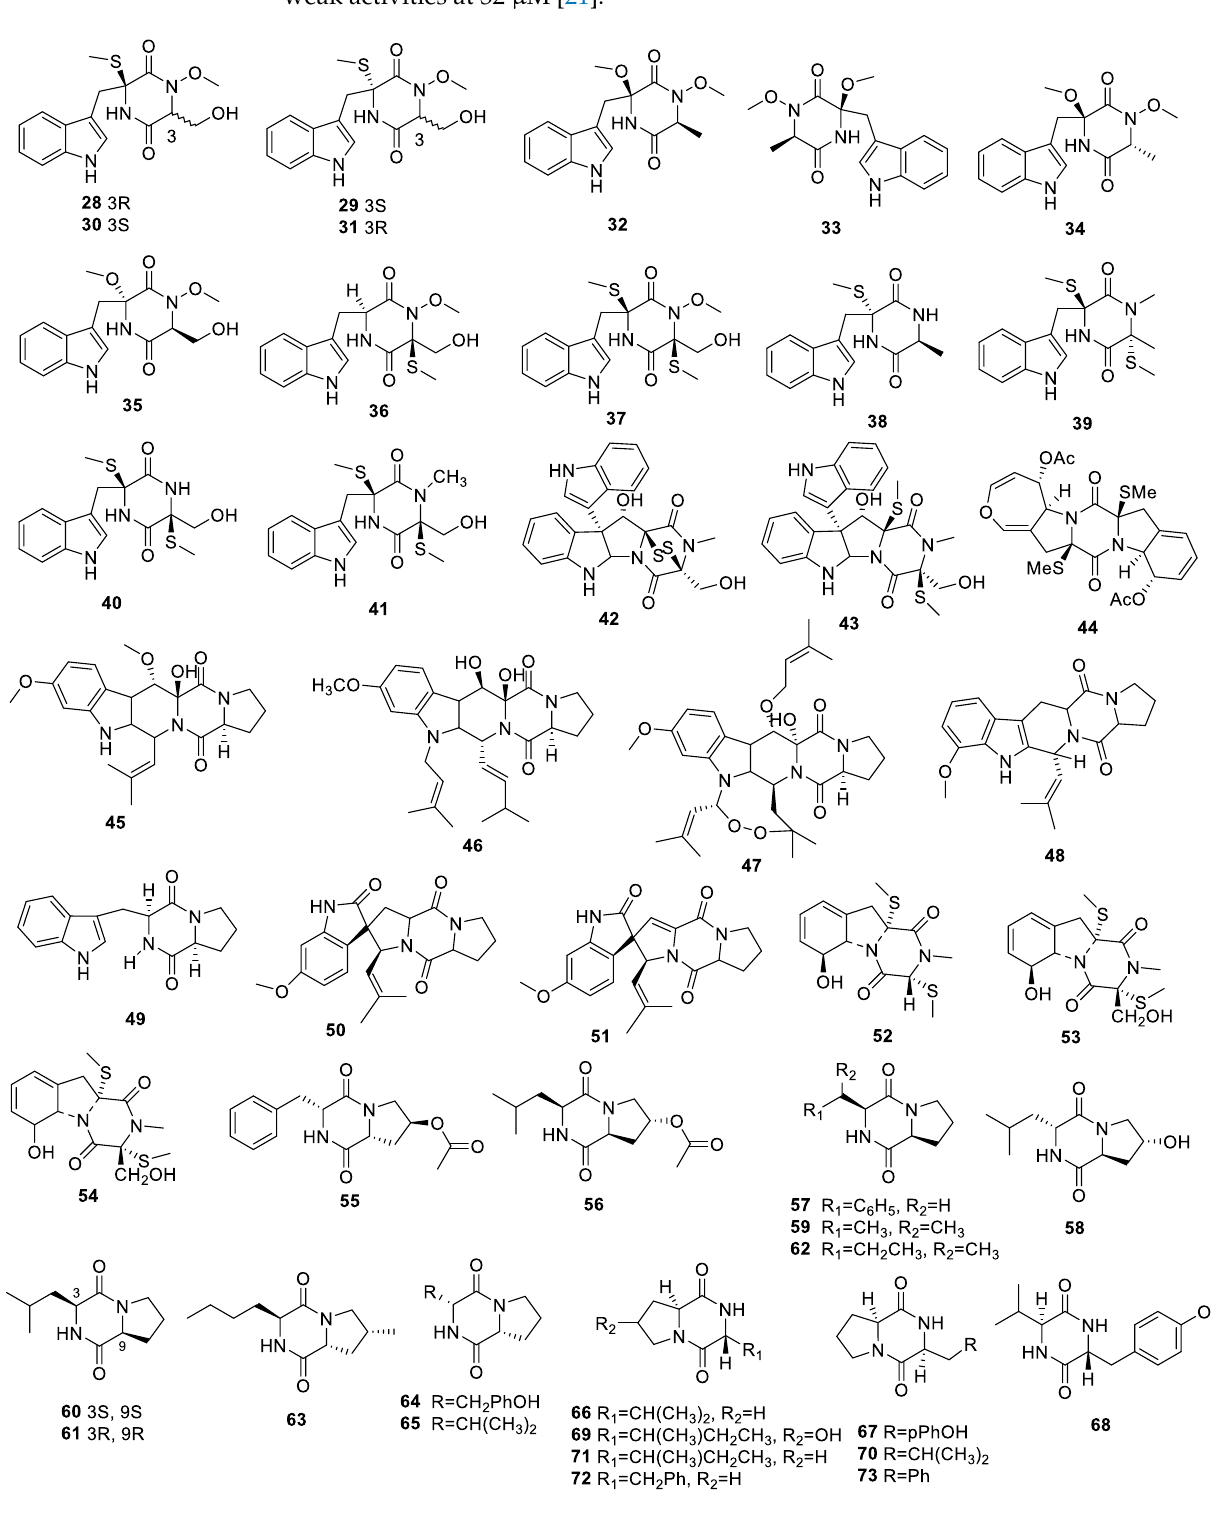
Figure 2. Chemical structures of diketopiperazine derivatives ( 28 – 73